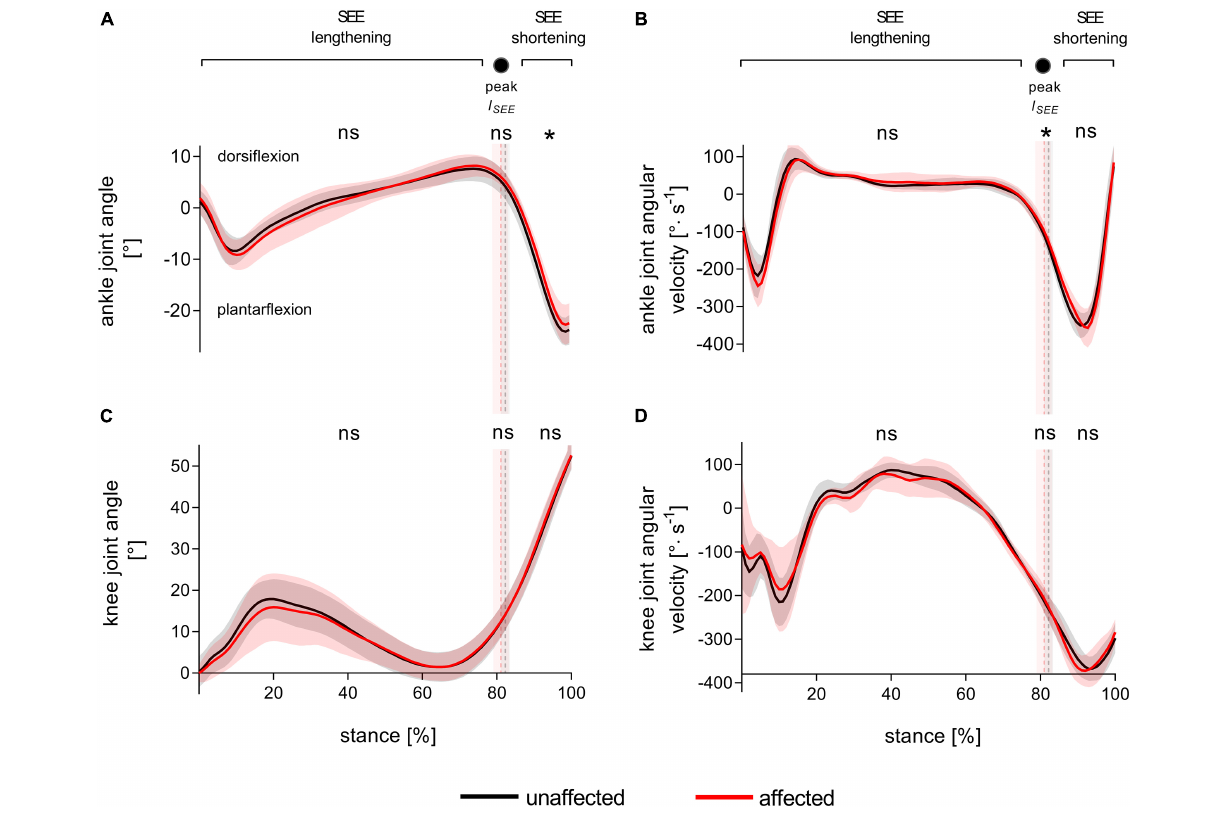
Frontiers in Physiology |